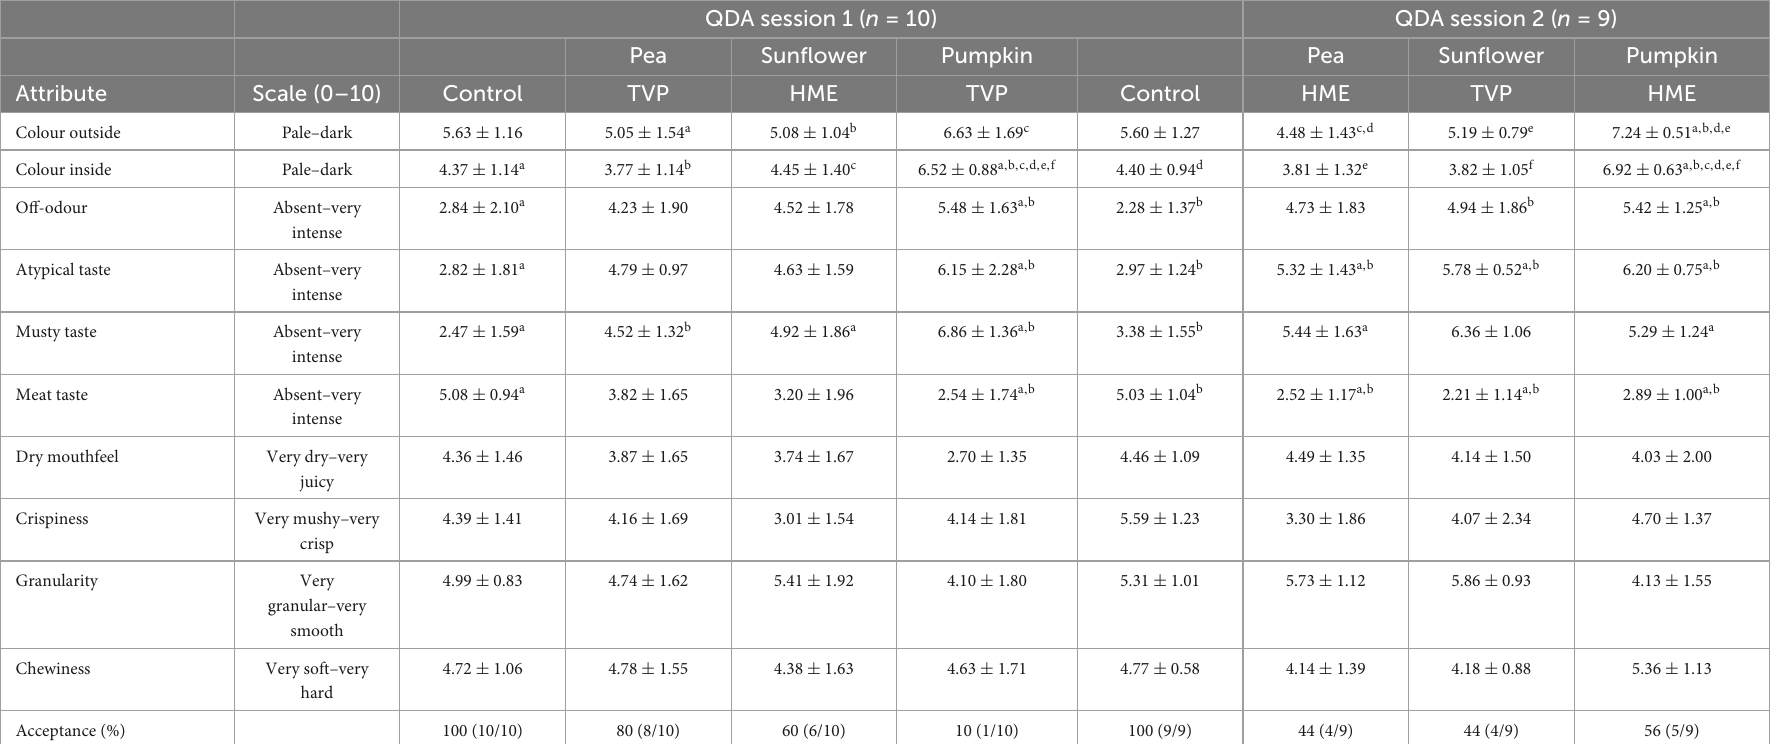
TABLE 3 Sensorial attribute scores (means ± SD) on a 10-point linear